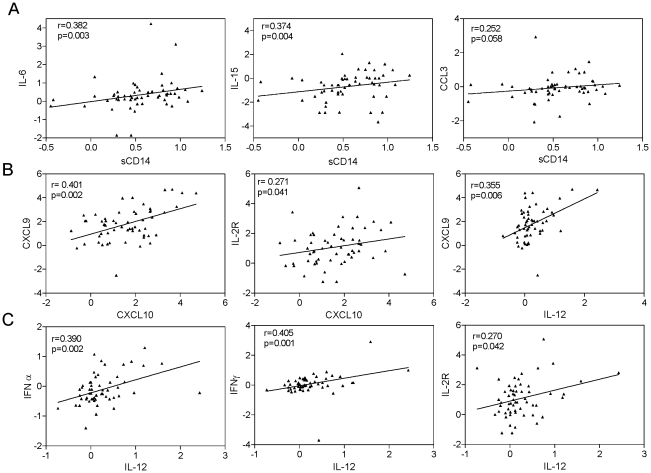
Inter-relationships between plasma inflammatory biomarkers and interferons in HIV subjects on cART.(A) Plasma sCD14 shows positive correlation with IL-6, IL-15, and trend towards significant correlation with CCL3. (B) CXCL10 correlated positively with CXCL9 andsIL-2R, while IL-12 was significantly associated with CXCL9. (C) IL-12 correlated positively with IFNα, IFNγ, and sIL-2R. Shown are log2 transformed values of measurements normalized to the mean of healthy controls. Data was analyzed by Spearman correlation, with p<0.05 considered significant.